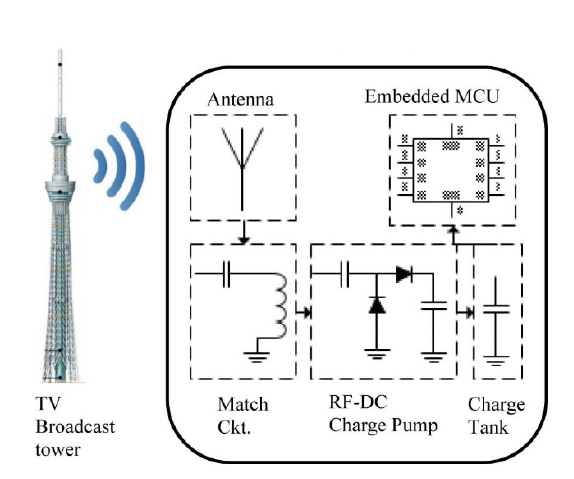
Figure 14. Prototype of a chip-based ambient (RF) energy-harvesting wireless sensor [45].